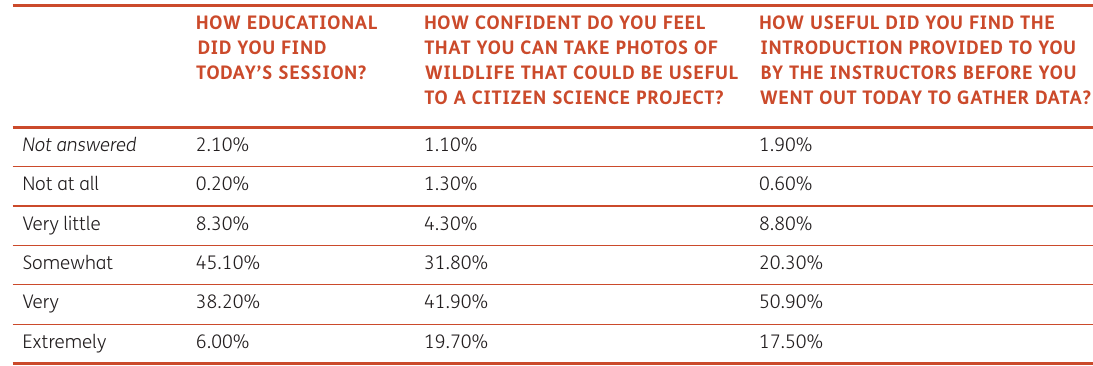
Table 3 Post-survey results: Regarding the educational value of the activity, about 90% of responses were positive responses in the Somewhat, Very or Extremely